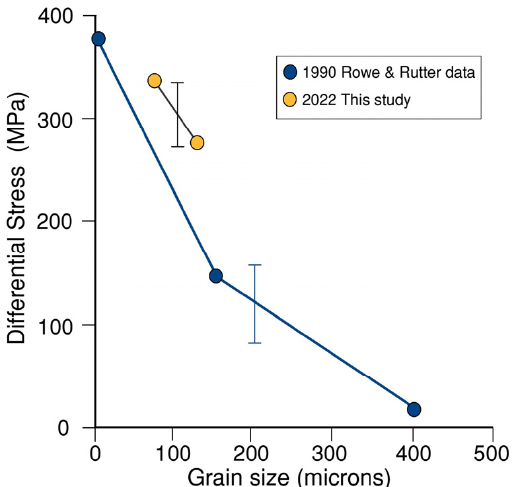
Figure 11. Relationship between differential stress and grain size for a twinning incidence of 20% (i.e., 20% of the grains in a particular grain size band contain twin lamellae). Thus at a given differential stress larger grains are more likely to contain twins, but there is no implication of the number of such twins. Shown are data of Rowe and Rutter [5] and the rather more restricted measurements that could be made on either side of the mean grain size in the present study.